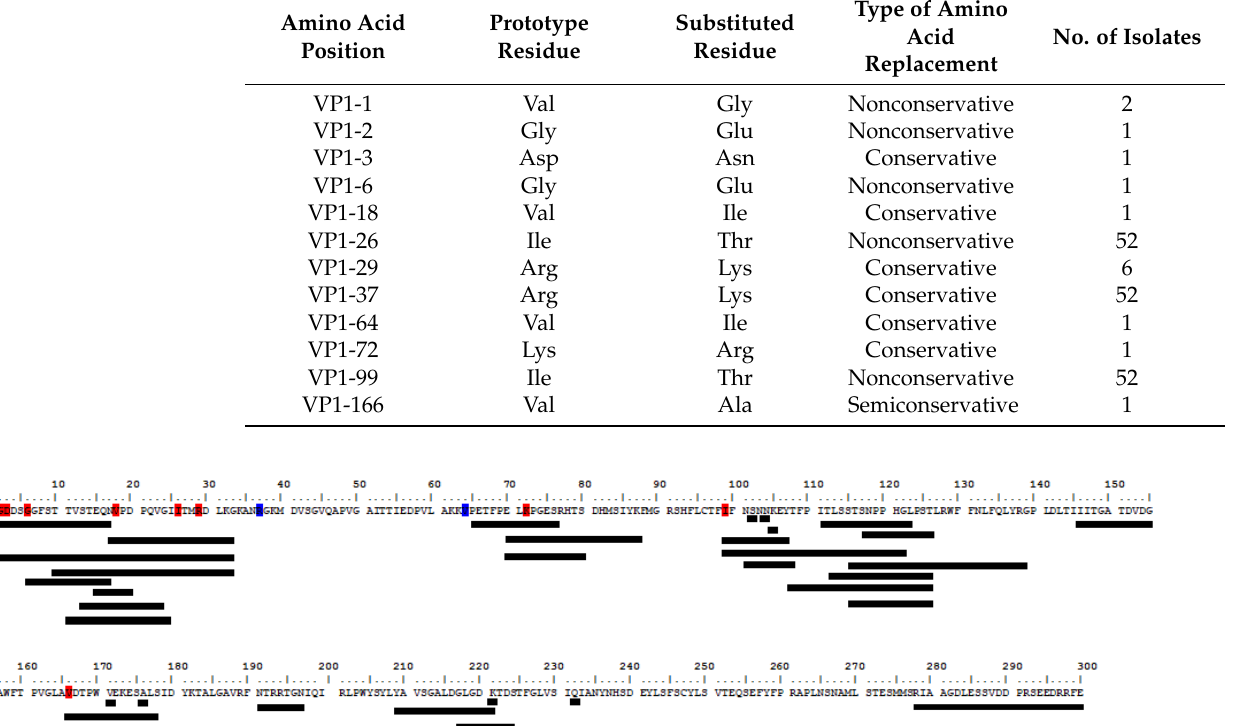
Table 1. Amino acid replacements identified in Tunisian strains isolated during 2013–2018 and their locations.